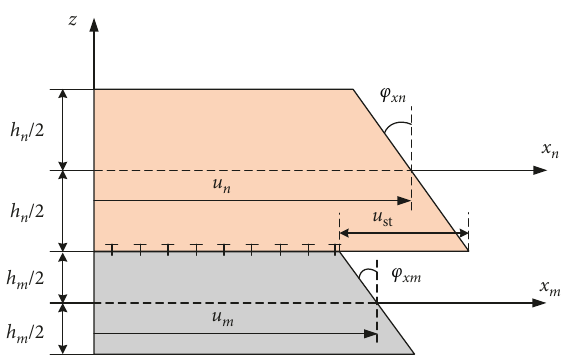
Figure 3: Axial displacement assuming a two-layer composite plate with connector